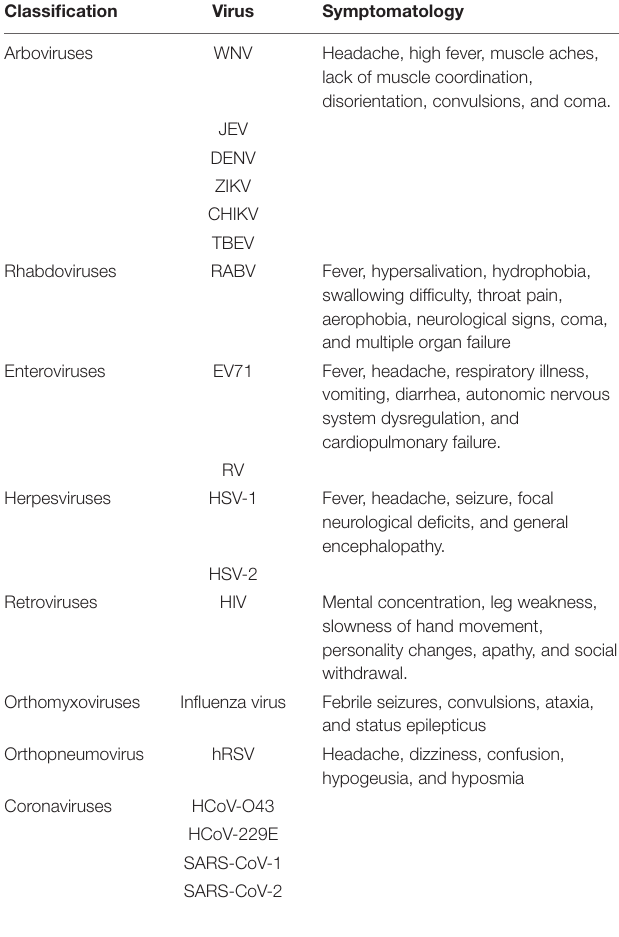
TABLE 1 | Viral agents causing encephalitis and